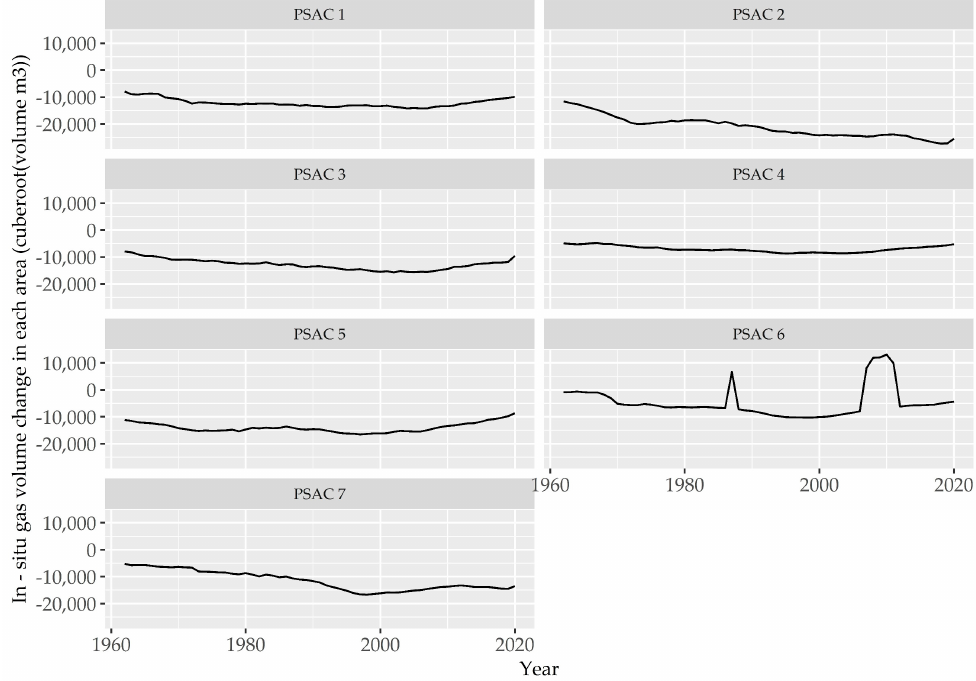
Figure 10. Calculated net annual gas balance trend in the Alberta Basin. Source data extracted from geoLOGIC Systems databases © 2020.